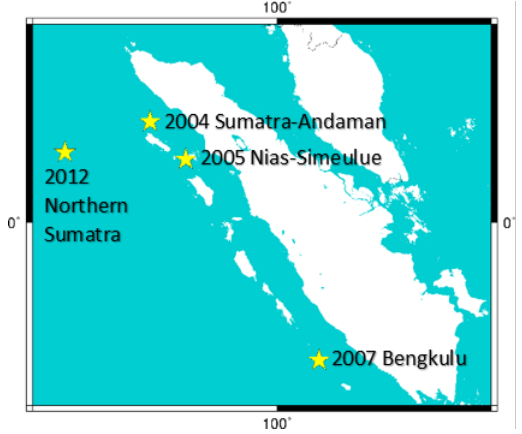
Figure 1. Location of epicenters for major earthquake affecting Malaysia from 2004 to 2013